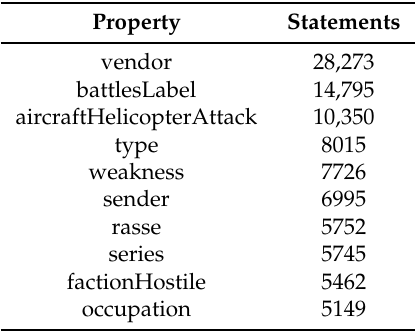
Table 11. The relations with the largest amount of extracted